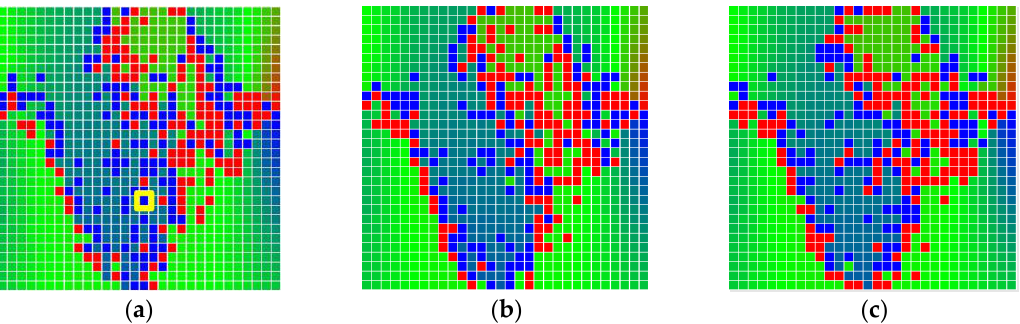
Figure 7. Deviation map observed for Roll estimate of the 2D Aruco grid board: ( a ) measurement 1, observe the highlighted square, this square is for the frame in Figure 5a; ( b ) measurement 5; ( c ) measurement 10.